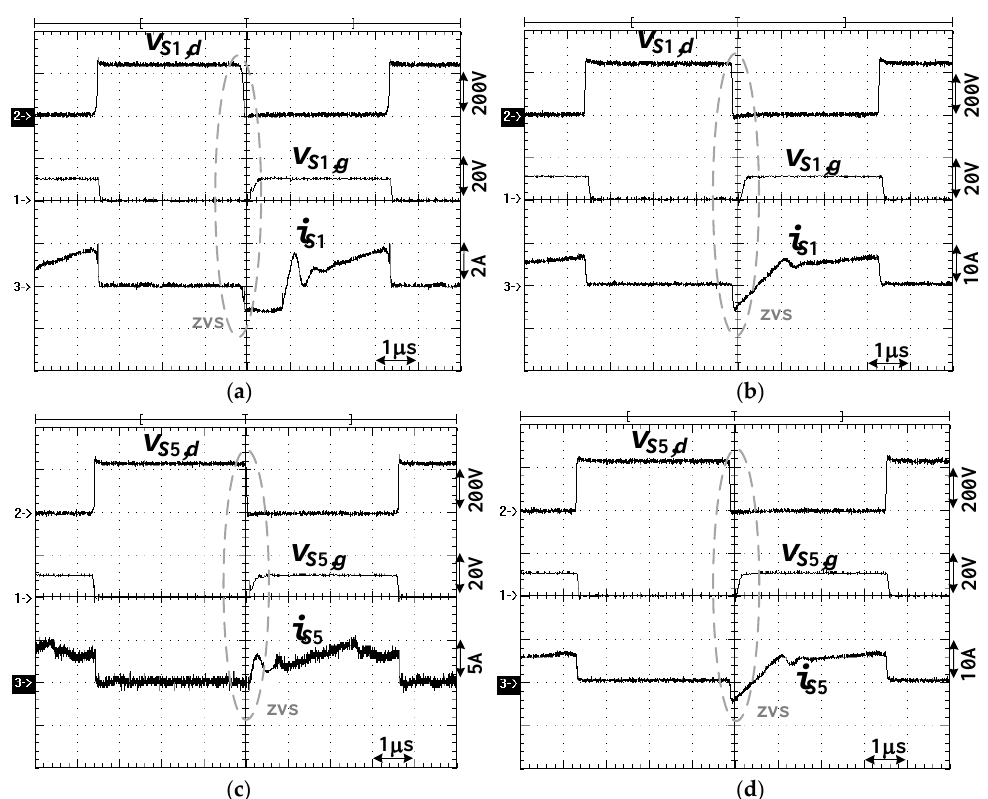
Figure 10. Test waveforms at V in = 250 V and P o = 800 W: ( a ) primary-side waveforms v S 1 ,g , v S 5 ,g , v ac , and i Lr 1 ; ( b ) secondary-side waveforms i D 1 , i D 2 , i Lo 1 , i Lo 2 , and i Lo 1 + i Lo 2 .